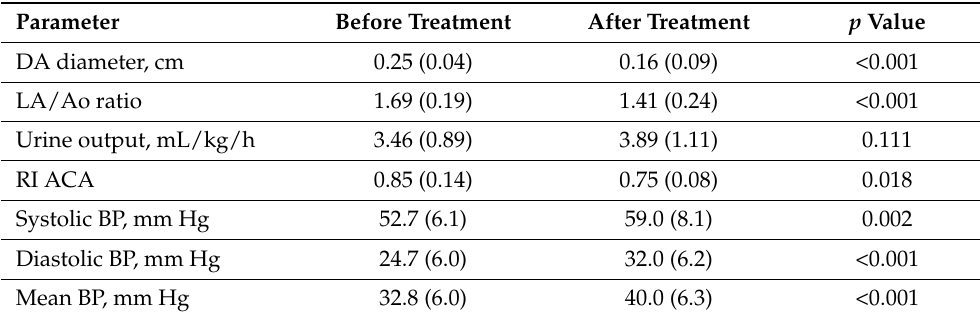
Table 2. Echocardiographic parameters before and after